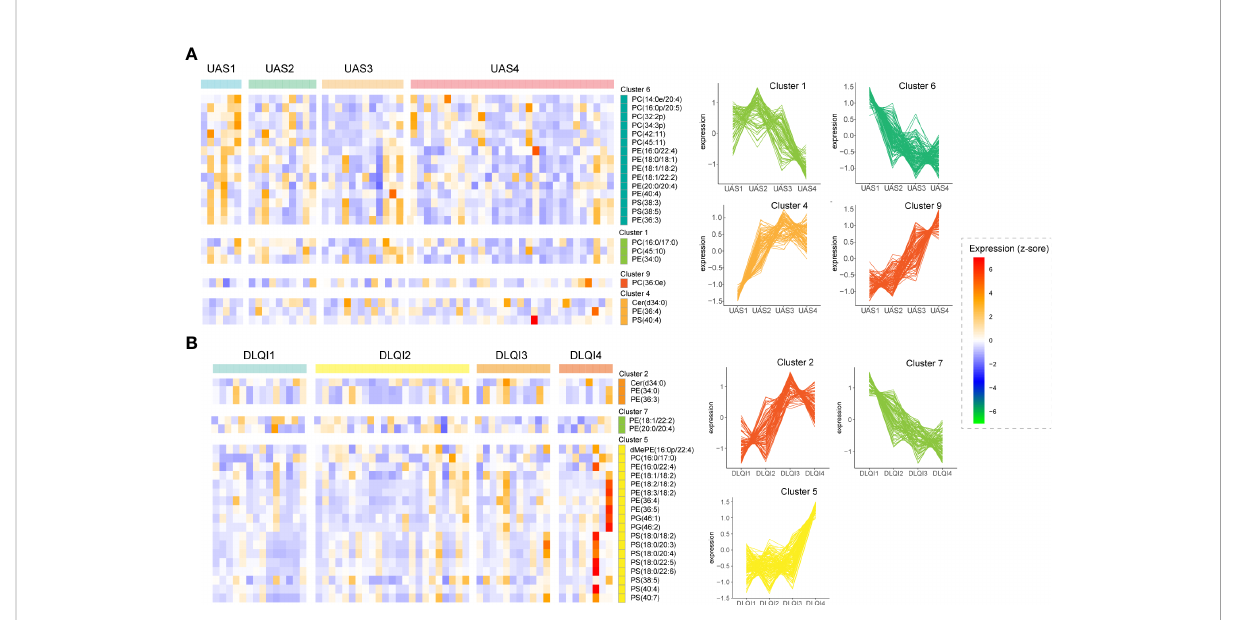
FIGURE 2 Alterations in lipids are related to the clinical characteristics of CU. Heatmaps of lipid clusters grouped by different UAS7 (A) and DLQI (B) scores are shown on the left. The abscissa marks the speci fi c scoring groups, and the ordinate marks the cluster and the major lipids in that cluster. The cut squares in the fi gure correspond to groups and clusters. Clusters with signi fi cant trends are on the